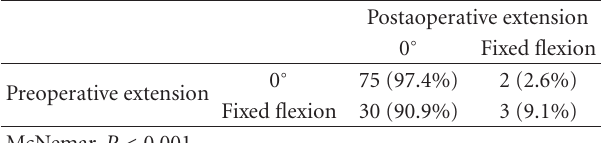
Table 2: Preoperative extension versus postoperative extension.